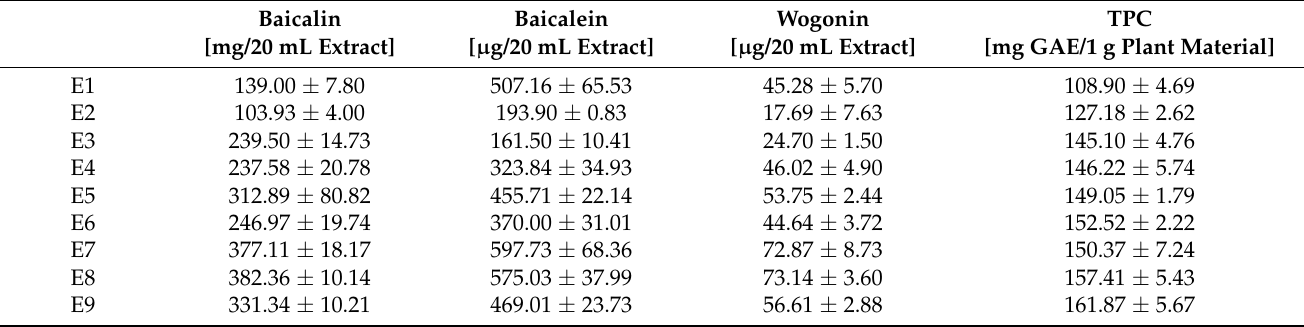
Table 3. Factorial Extraction Process Experiment